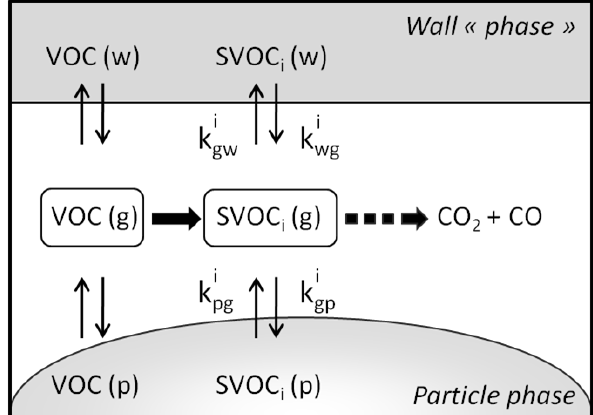
Figure 1. Schematic representation of gas–particle and gas–wall mass transfers of a semi-volatile organic produced during gaseous oxidation of